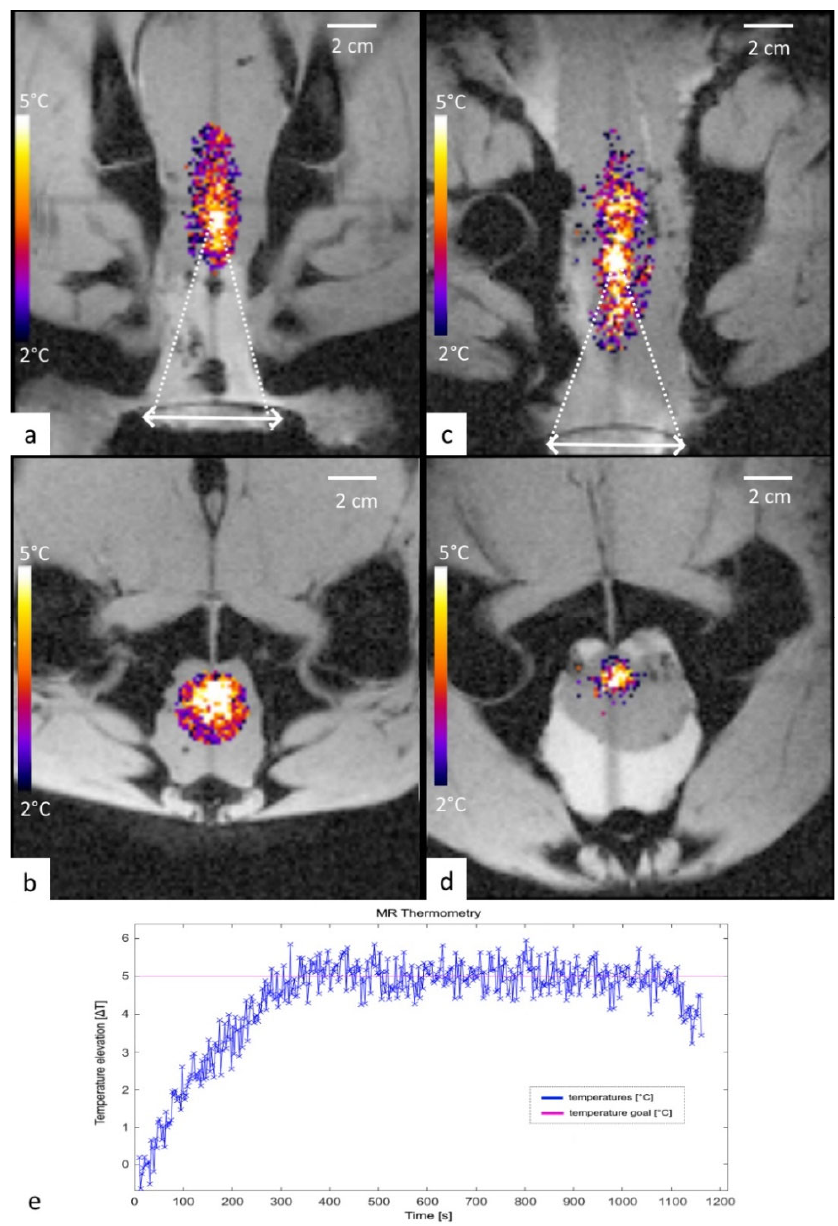
Figure 6. Experiment results for both carcass lamb. ( a – b ) MR thermometry in the coronal and axial geometry, a single focal point sonication shown at 6 min time point for lamb 1. ( c – d ) MR thermom ‐ etry in the coronal and axial geometry, a circular pattern of foci shown at 6 min time point for lamb 2. ( e ) Temperature versus time plot for lamb 1 at the focal point. ( e ) Temperature versus time plot for lamb 1 at the focal